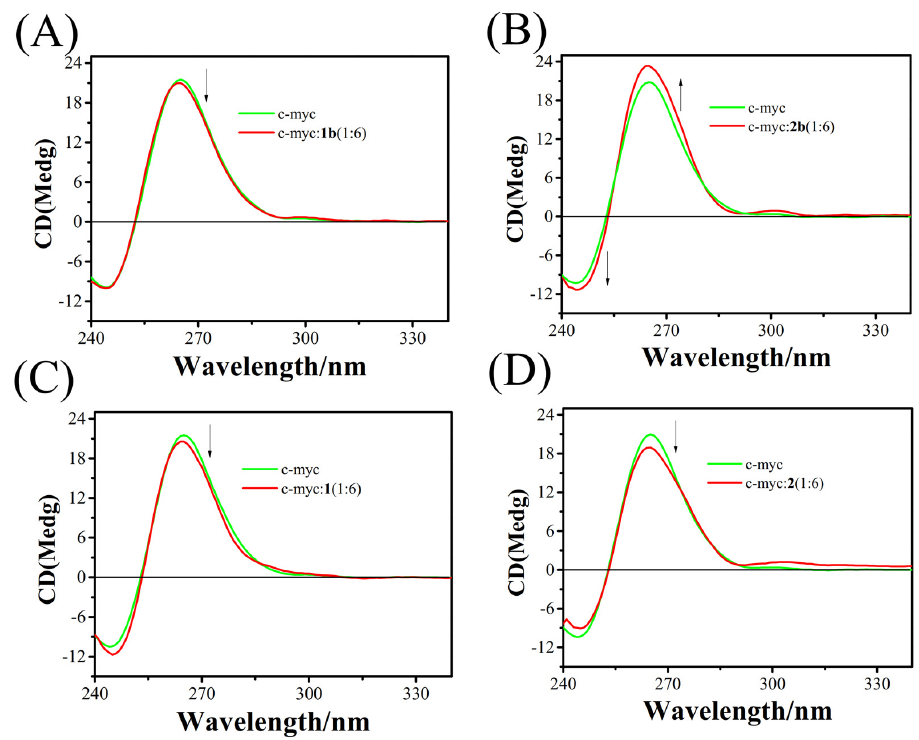
Figure 4. (A–D) Circular dichroism spectra of 1b ( A ) , 2b(B) , 1(C) , and 2(D) with c-myc G4 DNA (2 μ M) in 10 mM Tris-HCl-KCl buffer solution at pH